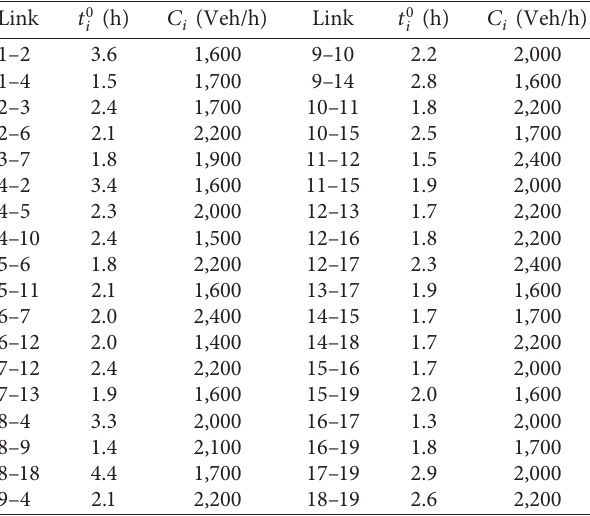
Table 1: Link attributes of the road